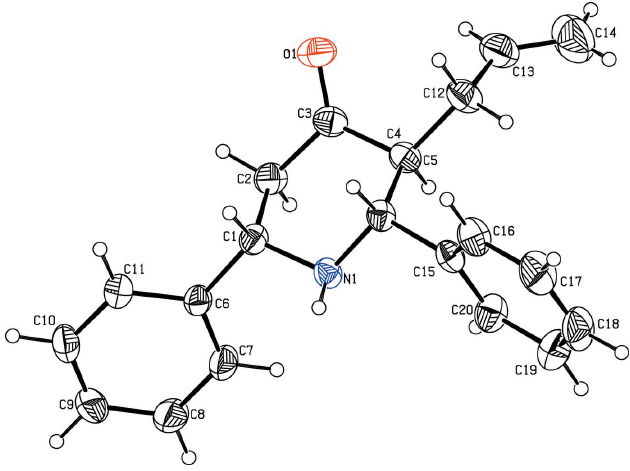
Figure 1 The molecular structure of the title compound, with the atom labelling. Displacement ellipsoids are drawn at the 30% probability level.